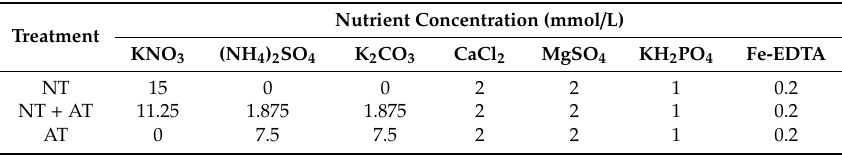
Table 1. Macronutrient composition of the hydroponic